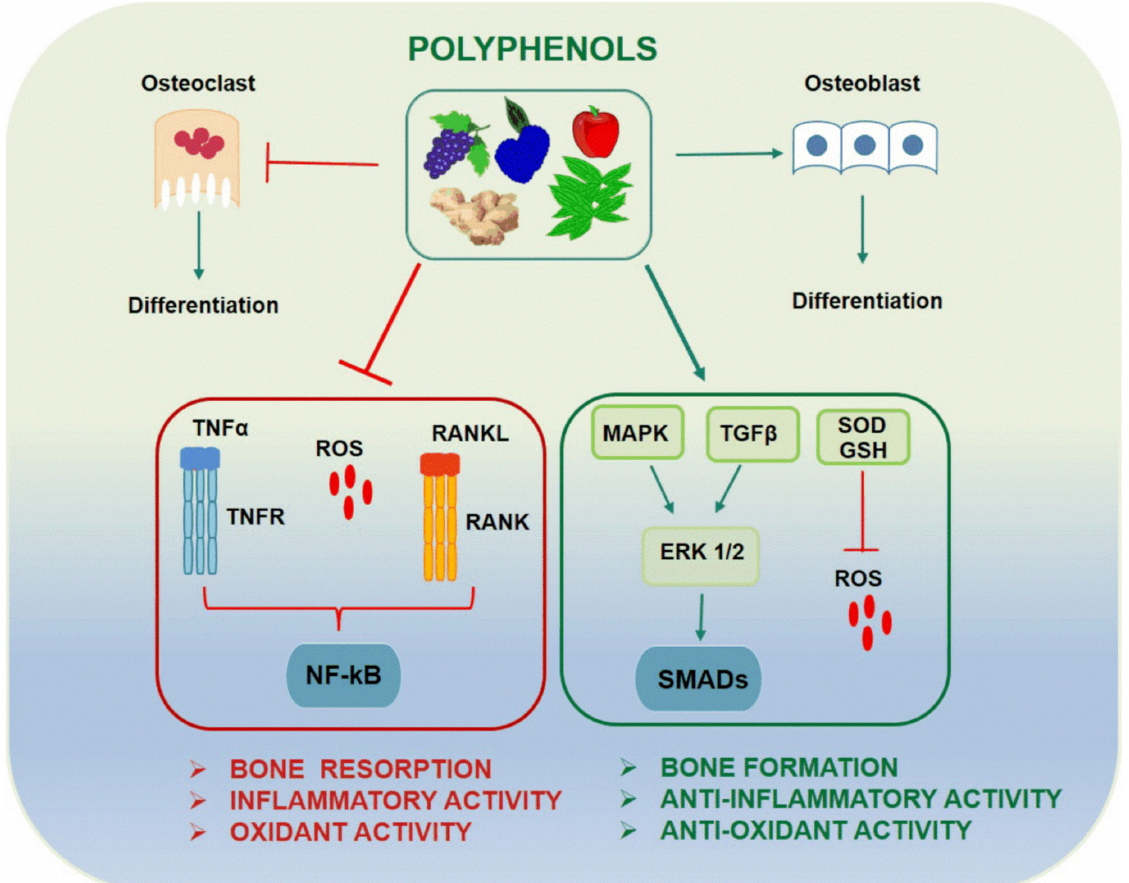
Figure 1. Signaling pathways involved in bone formation (green box) and bone resorption (red box). Polyphenols positively regulate MAPKs/TGF β /ERK1-2 pathway that activates and translocate Smads complex into the nucleus. Activated Smads regulate the expression of transcriptional factors and coactivators important in osteoblasts differentiation and bone formation process including Dlx5, Runx2, and Osx. Polyphenols also up-regulate genes involved in antioxidant activity such as superoxide dismutase (SOD) and glutathione synthetase (GSH). At the same time, polyphenols down-regulate RANKL and TNF α , two master gene regulators of osteoclasts differentiation and inflammatory pathways,